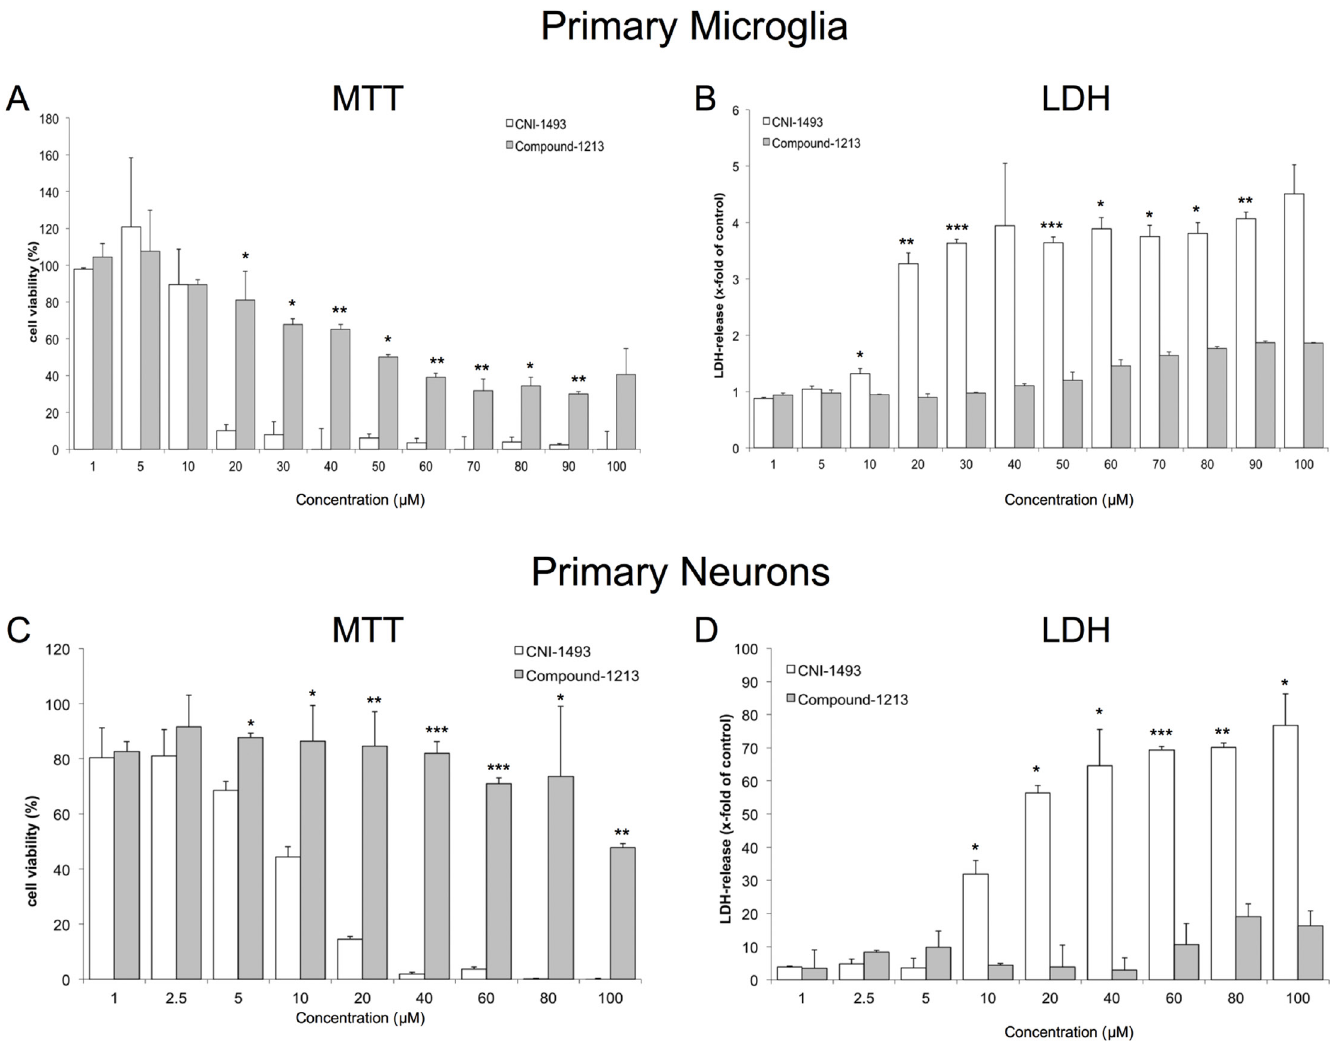
Figure 2. C1213 in vitro is considerably less toxic than CNI-1493. Primary microglia (A + B) and primary neurons (C + D) were treated with the indicated concentrations of CNI-1493 or Compound-1213 for 24 h. Cell proliferation (A + C) and cell death (B + D) were analyzed by MTT and LDH assay, respectively. * P < 0.05, ** P < 0.01, *** P <